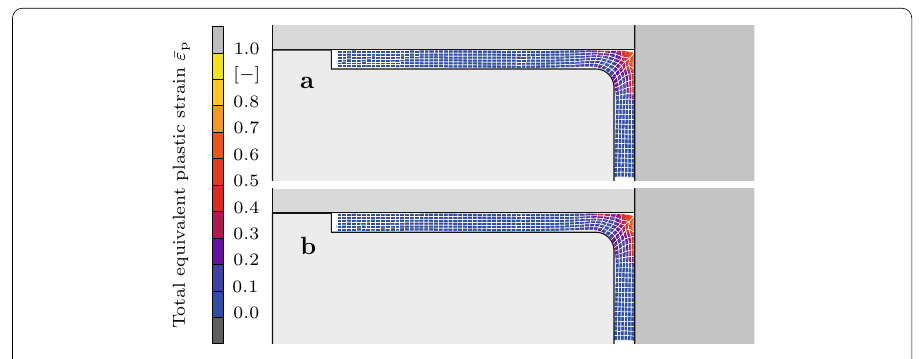
Fig. 15 Spatial (deformed) configurations according to the optimized material configurations. Figure 13a →